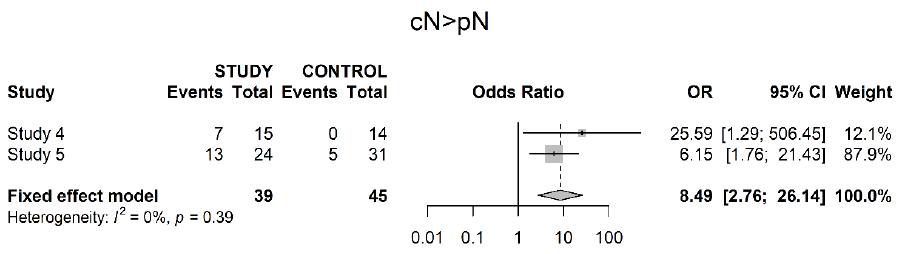
Figure 8. Downstaging from clinical to pathological lymph node stage.